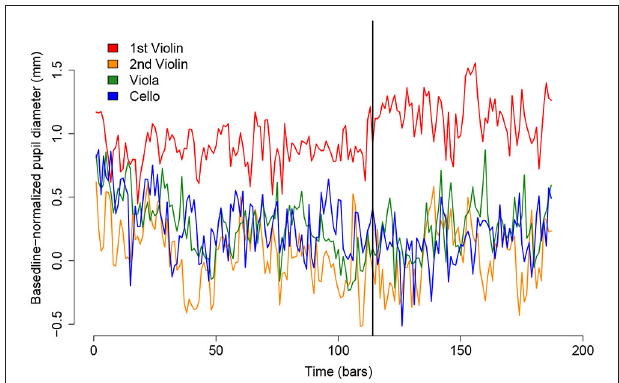
FIGURE 4 | Timecourse of pupil diameters for the quartet across the course of the 1st movement of the Haydn String Quartet. The black vertical line indicates the location of the 1st violinist’s failed page